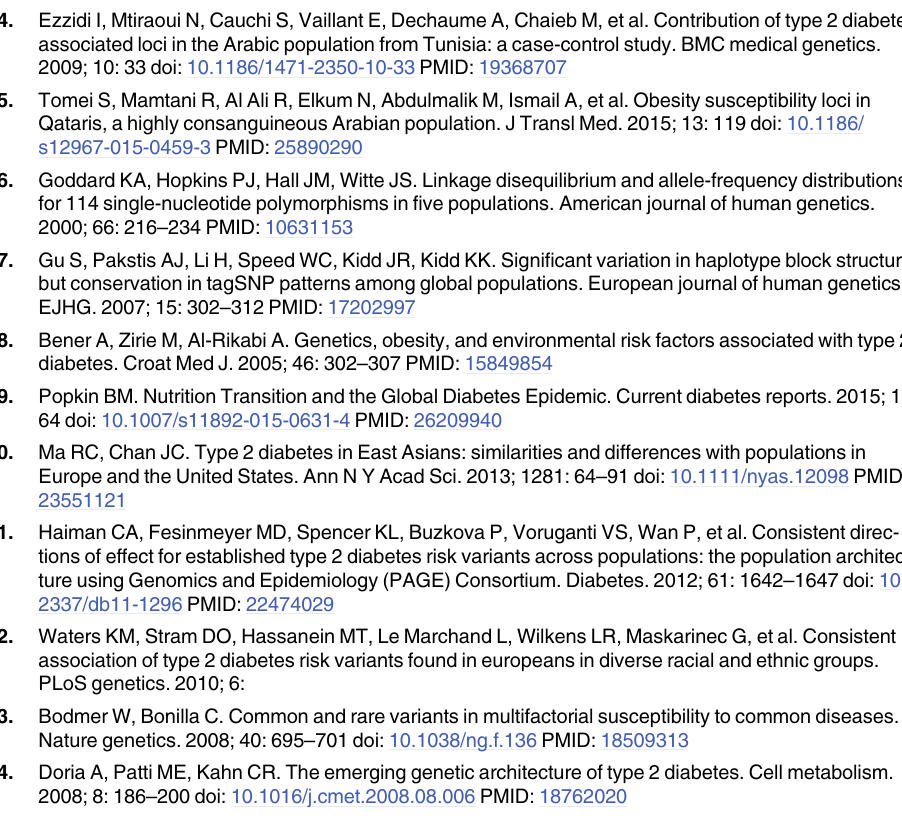
PLOS ONE | DOI:10.1371/journal.pone.0156834 July 6,